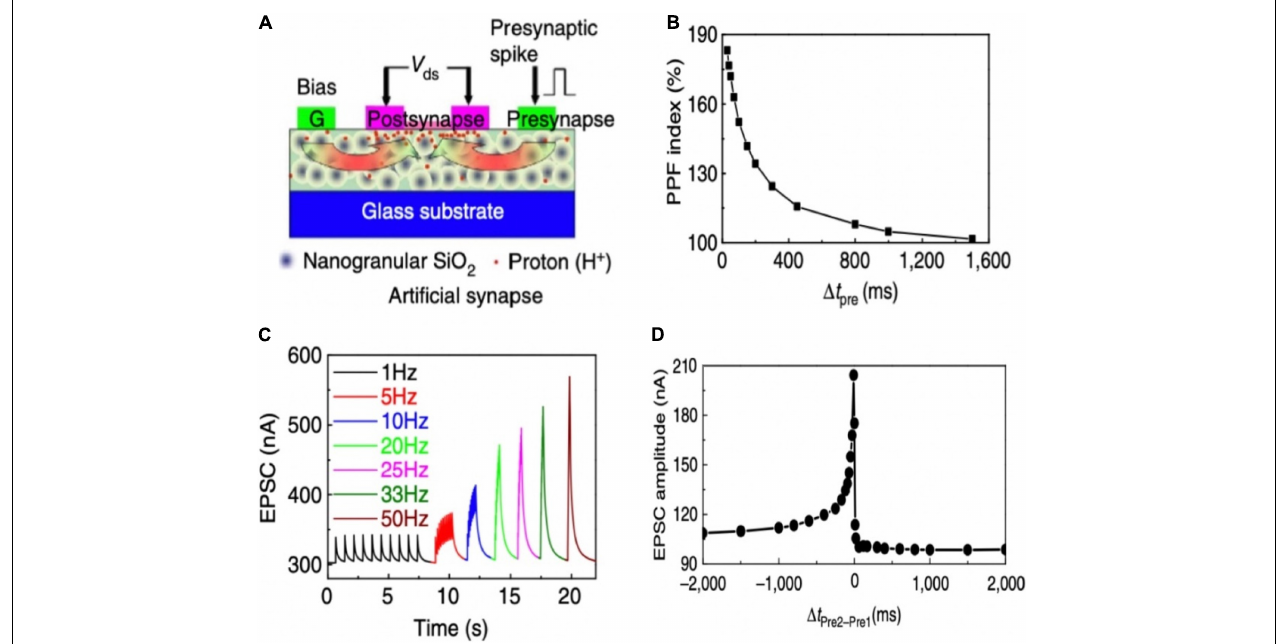
FIGURE 8 | (A) Illustration of a laterally coupled IZO synaptic device with two in-plane gates. (B) PPF behavior of the IZO synaptic transistor. (C) EPSCs triggered by the stimulus trains with different frequencies. (D) Dynamic logic testing of the IZO synaptic transistor (adapted from Zhu et al., 2014).